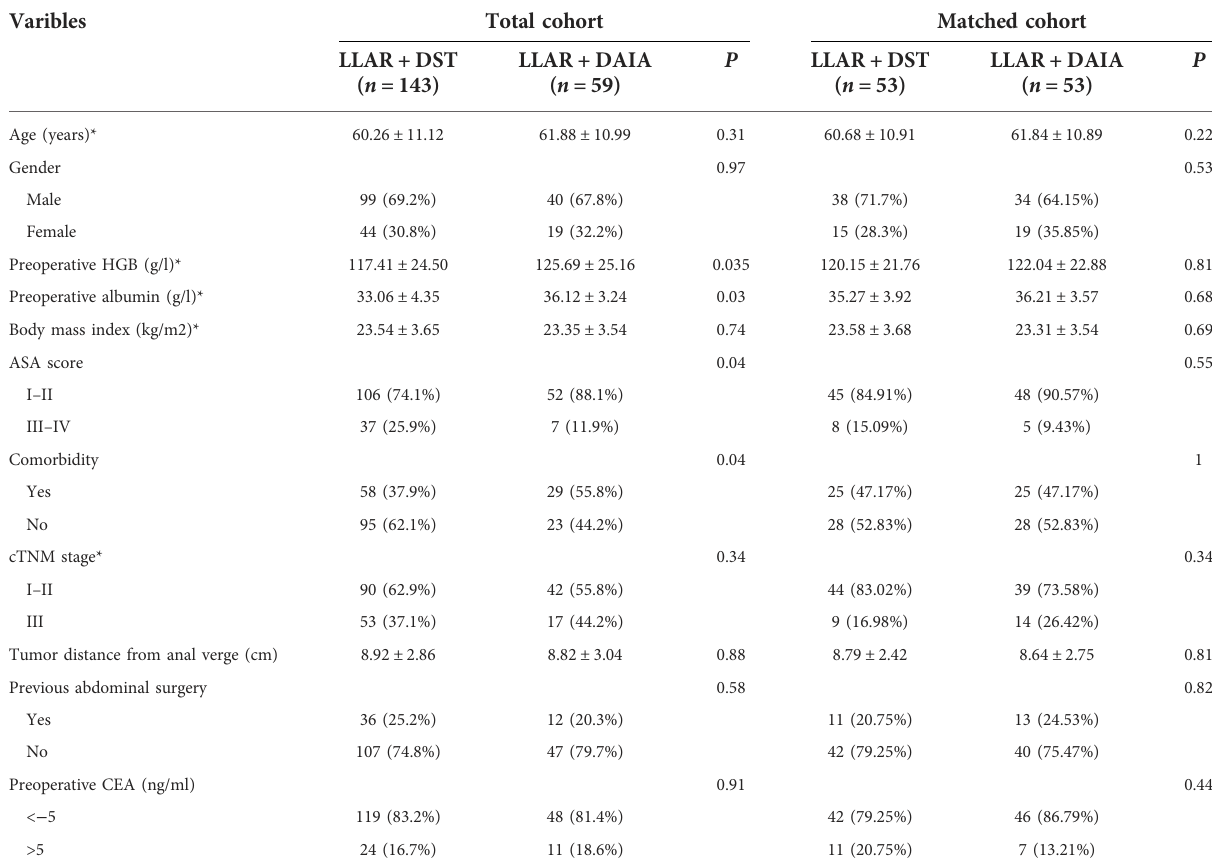
TABLE 1 Clinical and pathological characteristics of elderly patients with colorectal cancer before and after matching.